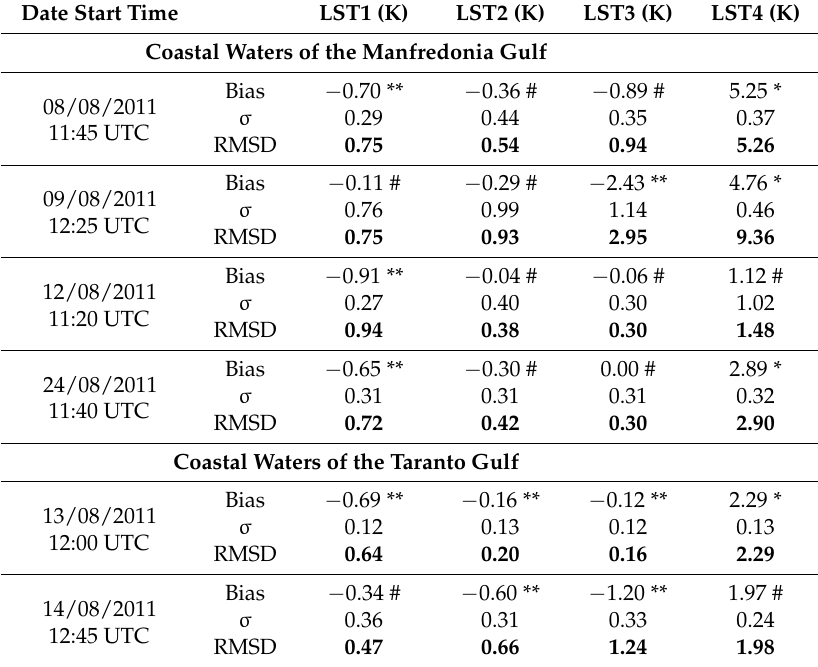
Table 4. Values of RMSD, bias, and σ between SST skin data and LST1, LST2, LST3, and LST4